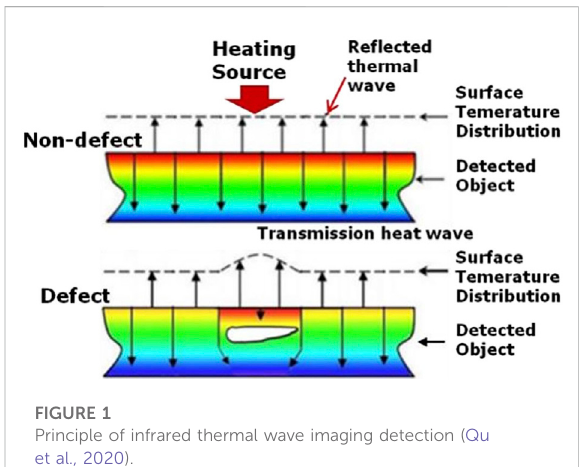
FIGURE 1 Principle of infrared thermal wave imaging detection (Qu et al.,